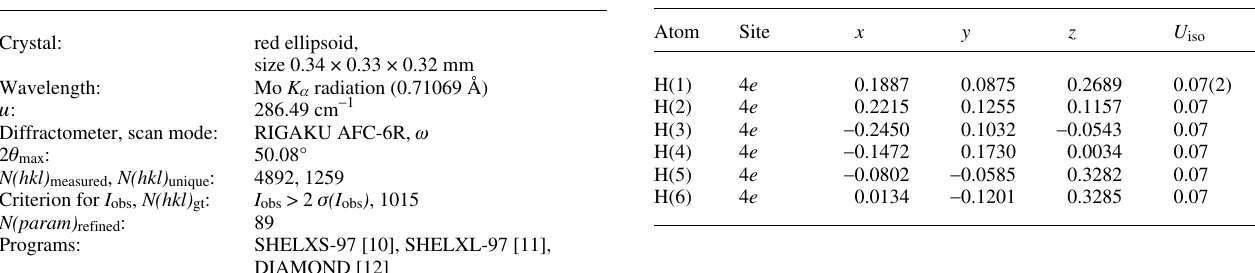
Table 8. Atomic coordinates and displacement parameters (in Å 2 ) .